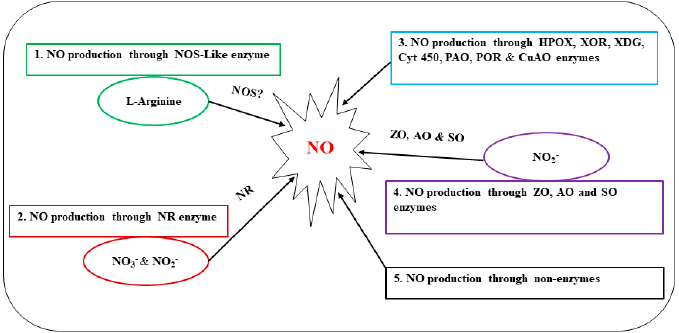
Figure 1. Production of NO through different pathways. Nitric oxide synthase (NOS), not discovered in higher plants (NOS?), Nitrogen oxide (NO), nitric oxide synthase (NOS), nitrate reductase (NR), nitrite ion (NO 3 − ), nitrate ion (NO 2 − ), horseradish peroxidase (HPOX), xanthine oxidoreductase (XOR), xanthine dehydrogenase (XDG), cytochrome (cyt P450), polyamine oxidase (PAO), polyamine oxidoreductase (POR), copperamine oxidase (CuAO), xanthine oxidase (ZO), aldehyde oxidase (AO), and sulfite oxidase